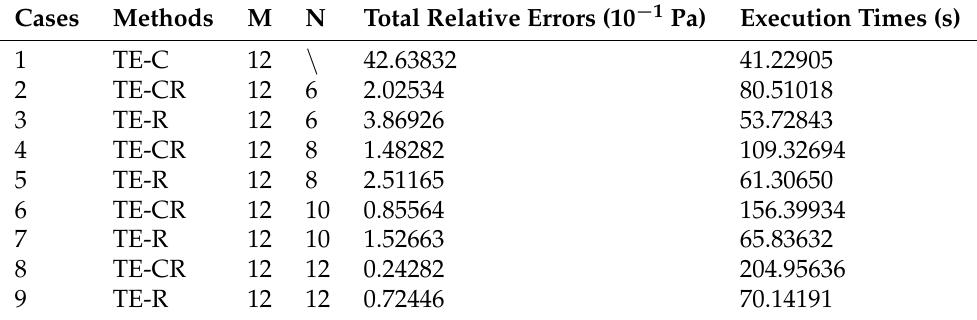
Table 2. Relative errors and CPU execution times of the TE-CR and TE-R methods with different orders N .